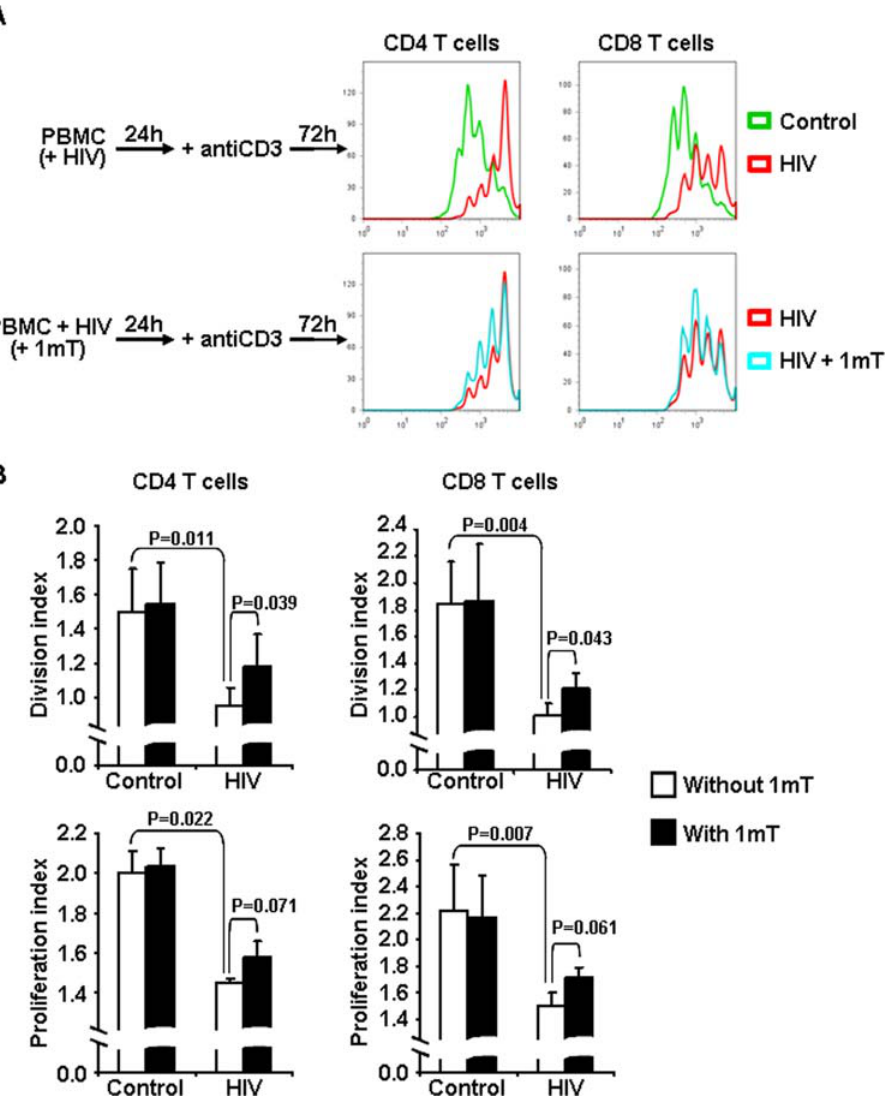
Figure 3. HIV exposure impairs T cell proliferative responses, contribution of IDO-mediated tryptophan catabolism. CFSE-labeled PBMC from HIV-uninfected donor were cultured for 24 hours in presence of control microvescicles, HIV alone, or in presence of the IDO inhibitor 1- methyl-D-tryptophan (1mT). After 24 hours anti-CD3 was added to the cultures and cells were analyzed by flow cytometry after 72 hours. ( A ) Flow cytometry histograms showing CFSE dilution for one example experiment for CD4 (left panels) and CD8 T cells (right panels) are shown. Upper panels show the comparison between control-pretreated cells (green line) and HIV-pretreared cells (red line); bottom panels show the comparison between HIV-pretreared cells (red line) and cells pretreated with HIV in presence of 1mT (Blue line). One representative of 5 independent experiments is shown. ( B ) Bar graphs showing division index (number of cell divisions/total cell number) and proliferation index (number of cell divisions/number of divided cells) of CD4 (left panels) and CD8 T cells (right panels) pretreated with AT-2 HIV or mock and stimulated with anti-CD3 in presence (solid bars) or absence (open bars) of 1mT. Mean values 6 standard error calculated on 5 independent experiments are shown.